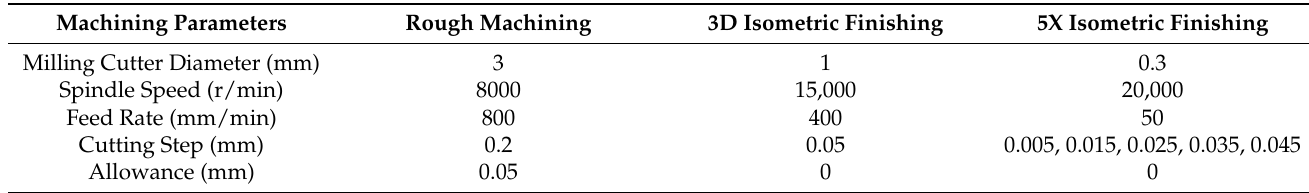
Table 3. Machining process and parameters of